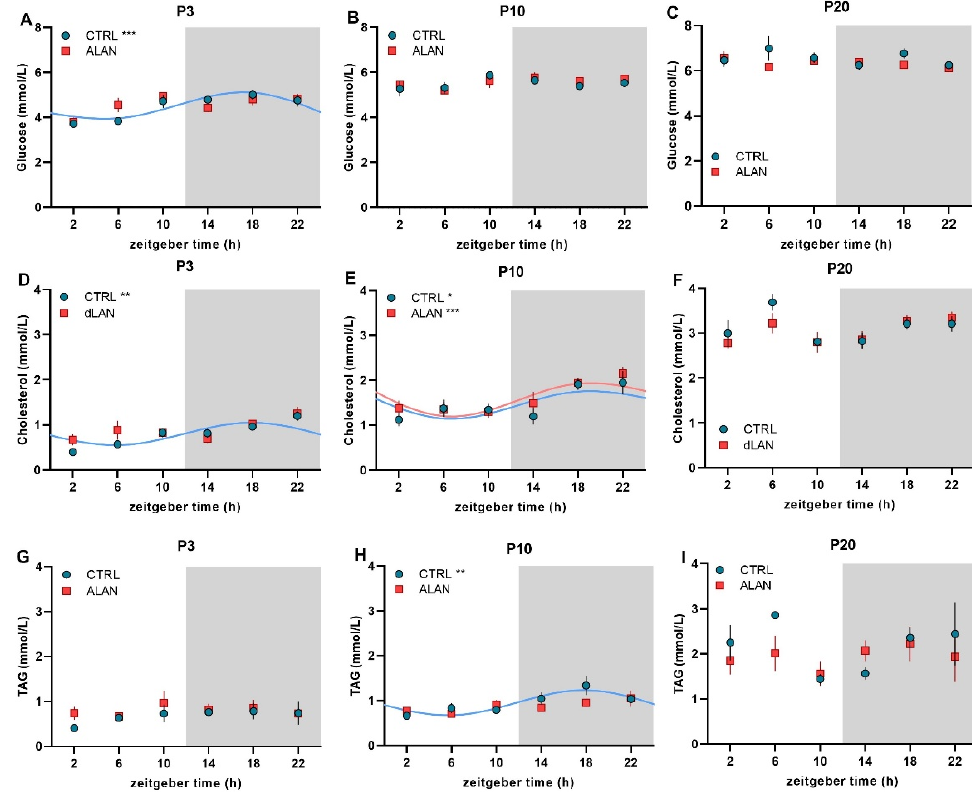
Figure 5. Effects of gestational dim ALAN (~2 lx) on the early development of daily rhythms in plasma metabolites. A daily profile of plasma glucose ( A – C ), cholesterol ( D – F ), and triacylglycerol (TAG) levels ( G – I ) on postnatal days P3 ( A , D , G ), P10 ( B , E , H ) and P20 ( C , F , I ) in rat pups that were delivered by mothers exposed to either the control light–dark cycle (CTRL) or ALAN during pregnancy. Symbols represent the mean ± SEM, n = 4–6 rats per time point and group. The significant 24-hour rhythms are fitted with a cosine curve for CTRL (blue solid line) and ALAN (red solid line) groups at *** p < 0.001, ** p < 0.01, and * p < 0.05. Non-rhythmic data are not fitted with the cosine curve. Zeitgeber time 0 = light on. Grey areas represent the dark phase. Table 3. Cosinor analysis of daily rhythms for plasma glucose (GLU), cholesterol (CHOL), and triacylglycerol (TAG) levels in rat pups that were delivered by mothers exposed to either the control light–dark cycle (CTRL) or dim ALAN during pregnancy. Rats were sampled at three developmental stages, on postnatal days P3, P10, and